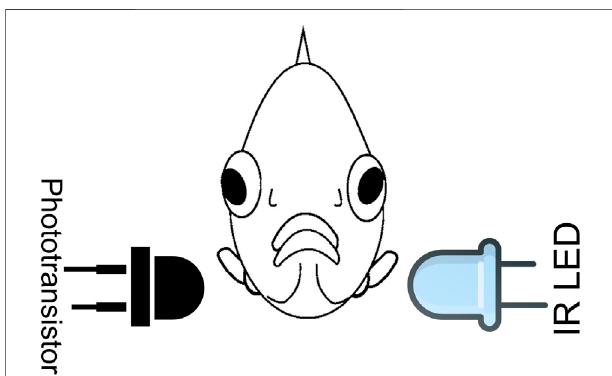
FIGURE 4 | Sensor arrangement relative to the zebra fi sh (front view). Adapted from (Yoshida, Hirano and Shima, 2009).